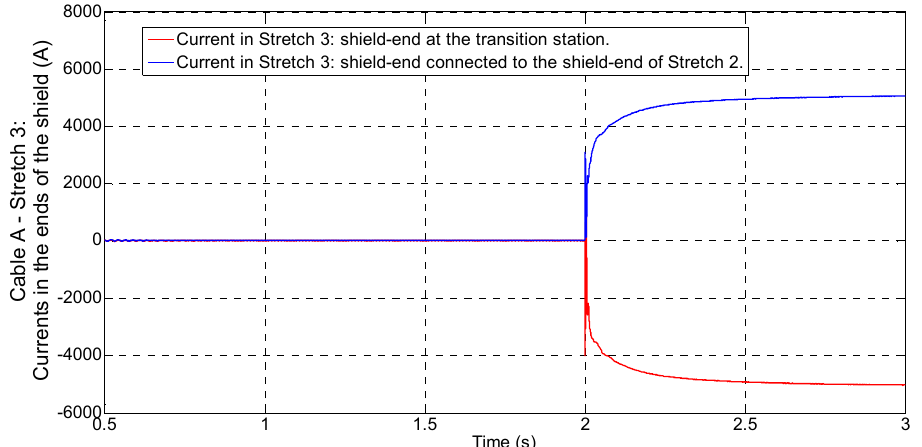
Figure 11. Circulation of ground fault currents in the ends of the shield in Stretch 3 of Cable A in case of external ground fault in Cable A, Stretch 1.